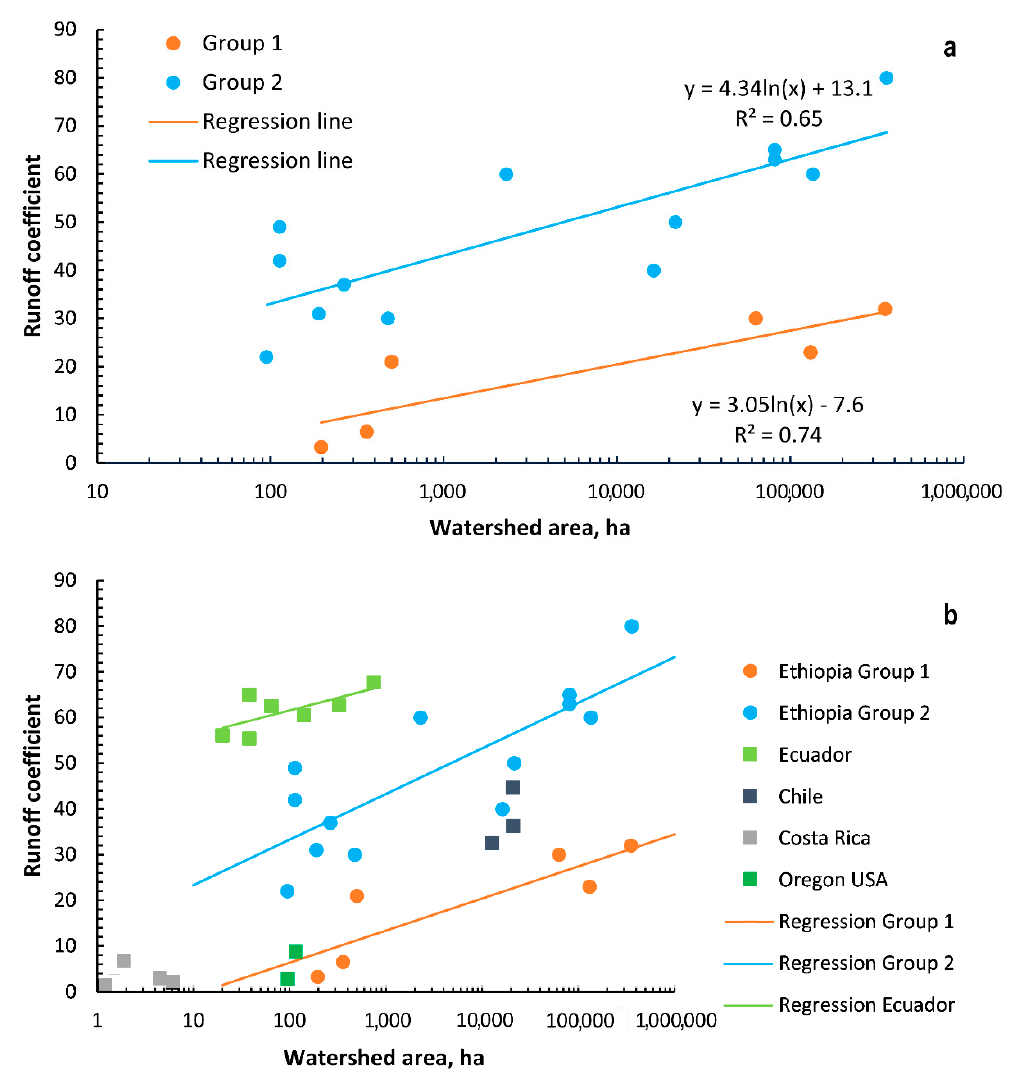
Figure 12. The relation between runoff coefficient (RC) and watershed area. ( a ) Ethiopian Highlands Orange dots indicate group 1 watersheds including Gomit, Tikur Wuha, Megech, Rib, and Beles. Blue dots show group 2 watersheds including Gumara, Gilgel Abay, Dirma, Gibera, Gelda, Koga, Maybar, Anjeni, Andit Tid, Debre Mawi, May Zeg Zeg, Birr, and Guale (Table A3) watershed in the volcanic mountainous area in the world (squares, see Table A4 in the Appendix A for more information). ( b ) the Ethiopian highland watersheds and some global volcanic watersheds from Ecuador, Chile, Costa Rica and USA